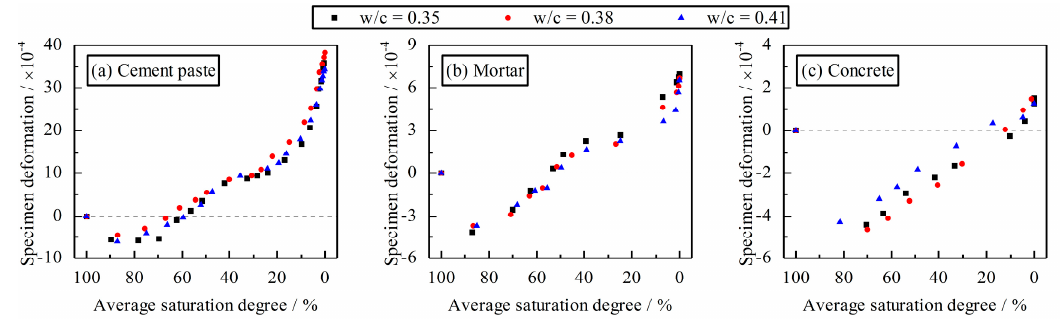
Figure 6. Deformations in drying process of concrete at three scales, ( a ) cement paste ( b ) mortar ( c ) concrete.